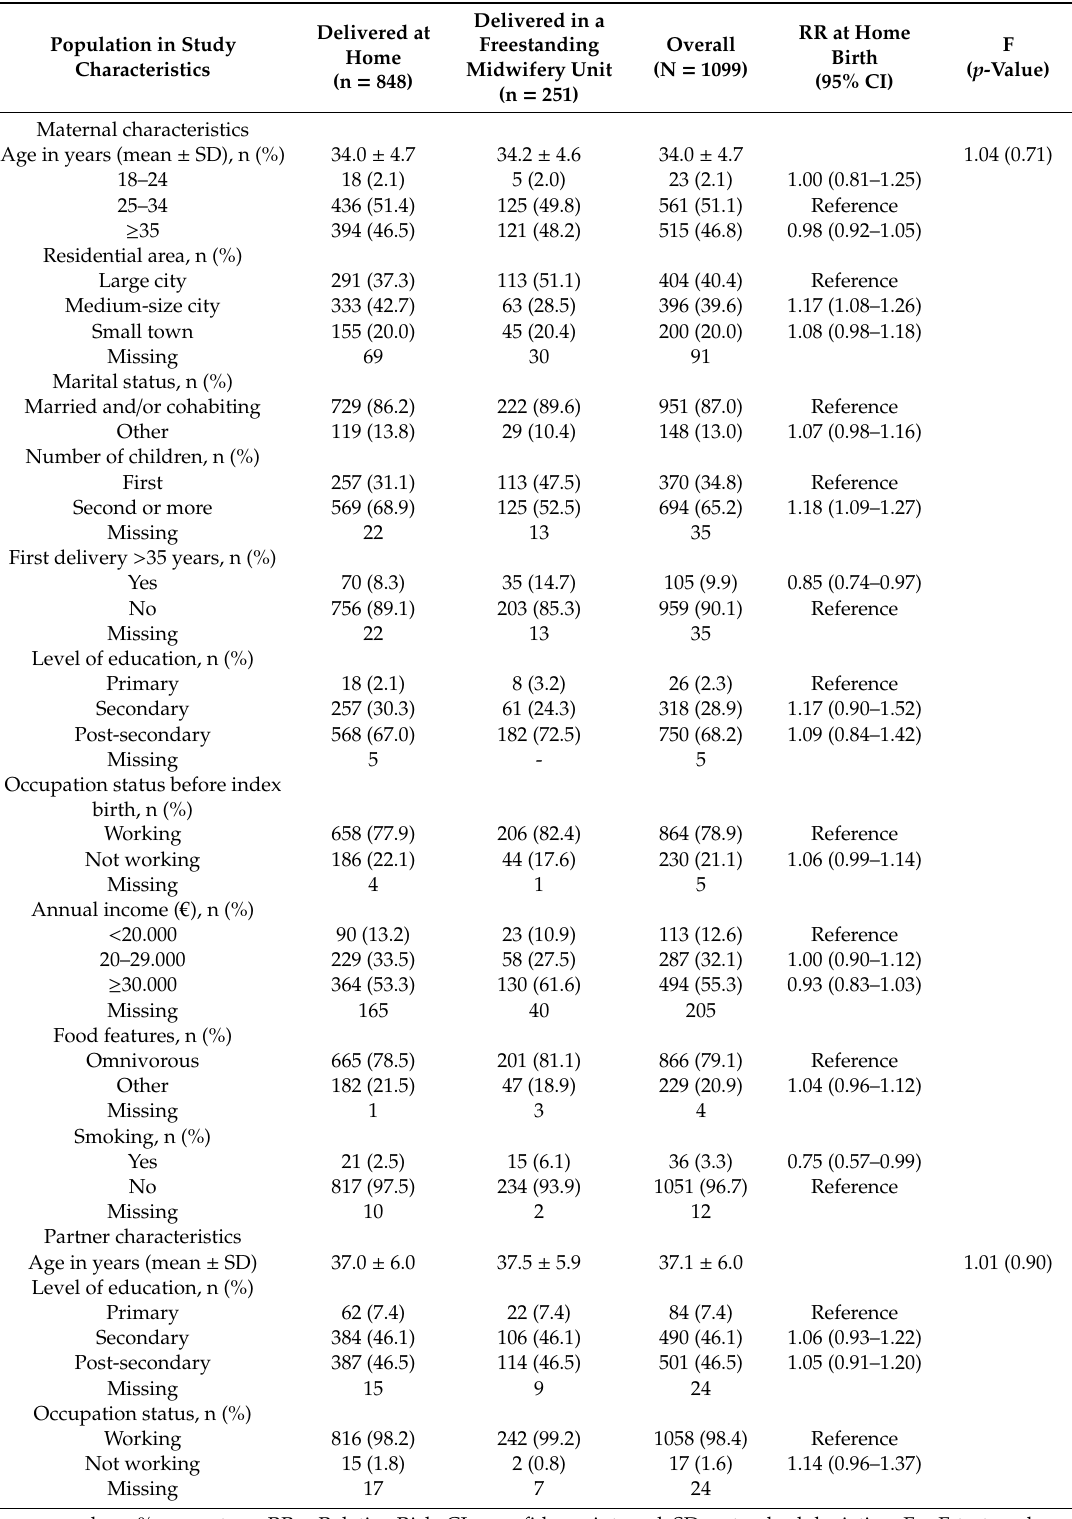
Table 1. Maternal and partner characteristics by birth at home or in a midwifery